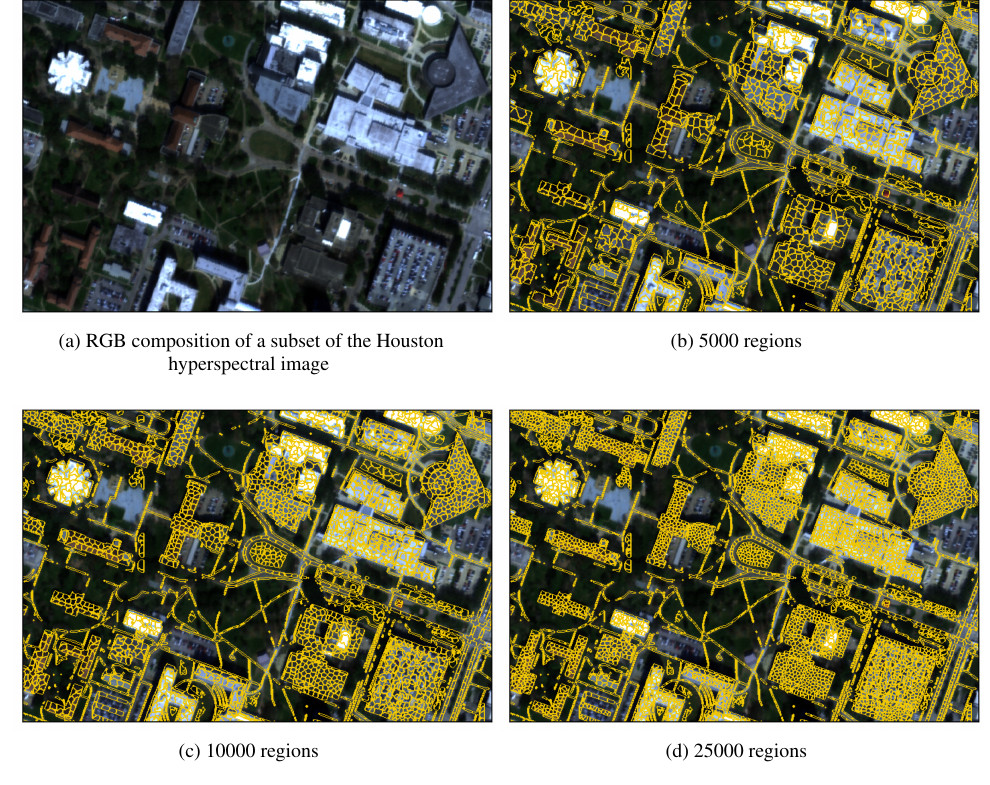
Figure 1. Visualization of different SLIC segmentations (using the first three components of a PCA) on a Houston unlabeled